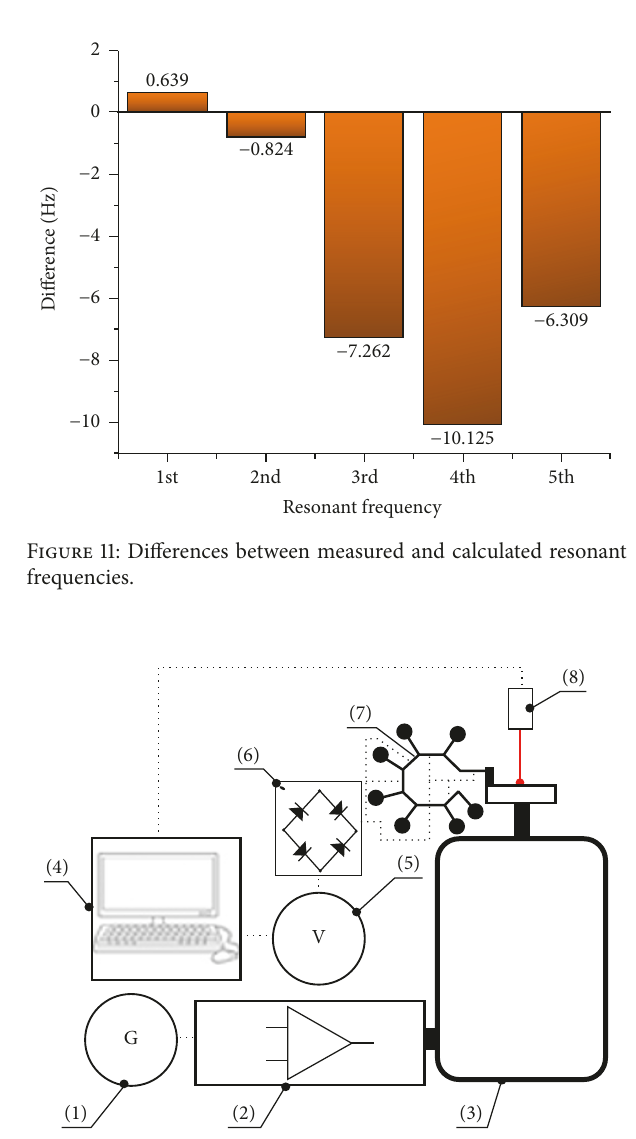
Figure12:Experimentalsetup; (1) functiongenerator; (2) amplifier; (3) electromagnetic shaker; (4) computer; (5) data logging multime- ter; (6) electronic interface; (7) harvester; (8) displacement